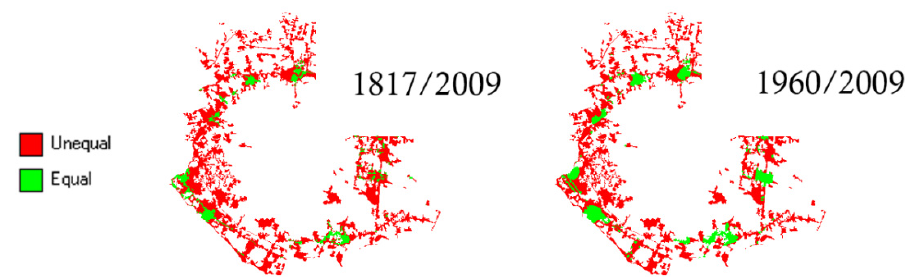
Figure 10. Land use changes in maps comparisons.